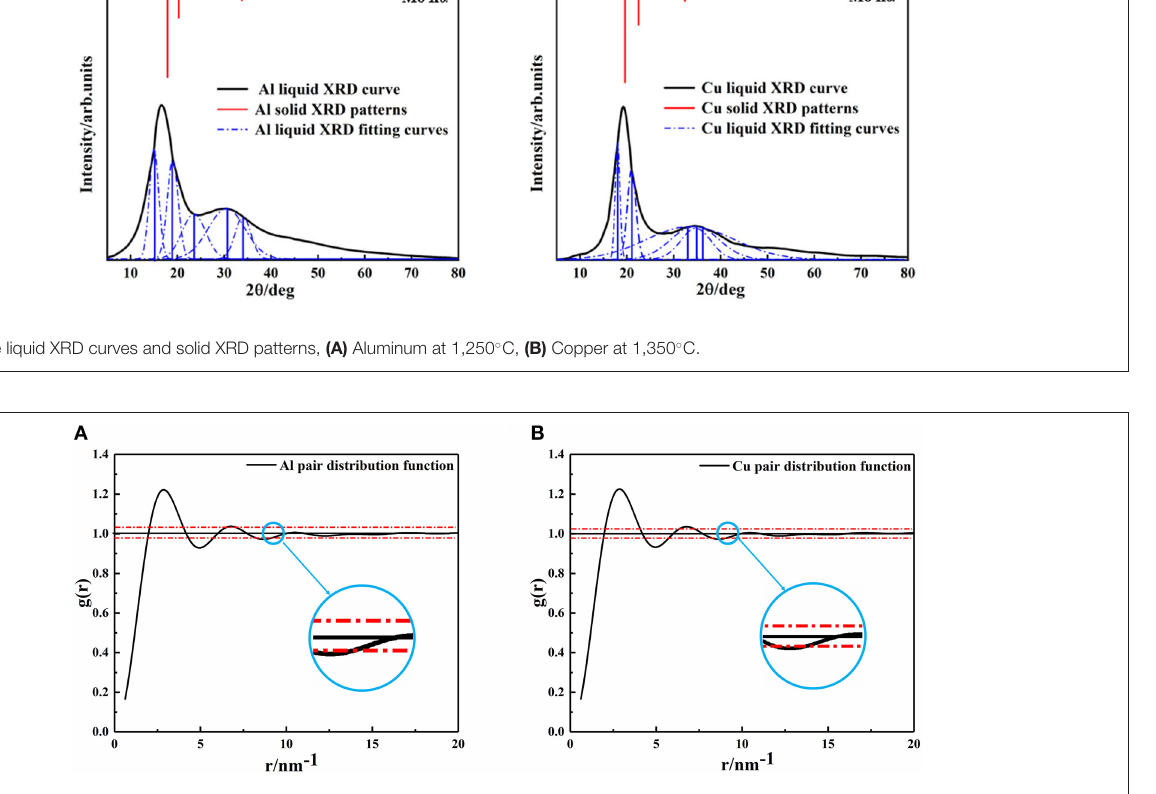
FIGURE 2 | The pair distribution function curves, (A) Aluminum at 1,250 ◦ C, (B) Copper at 1,350 ◦ C. The last intersection position of red dashed lines and PDF curves were enlarged, and the abscissa corresponding to the intersection is the radius of the cluster.